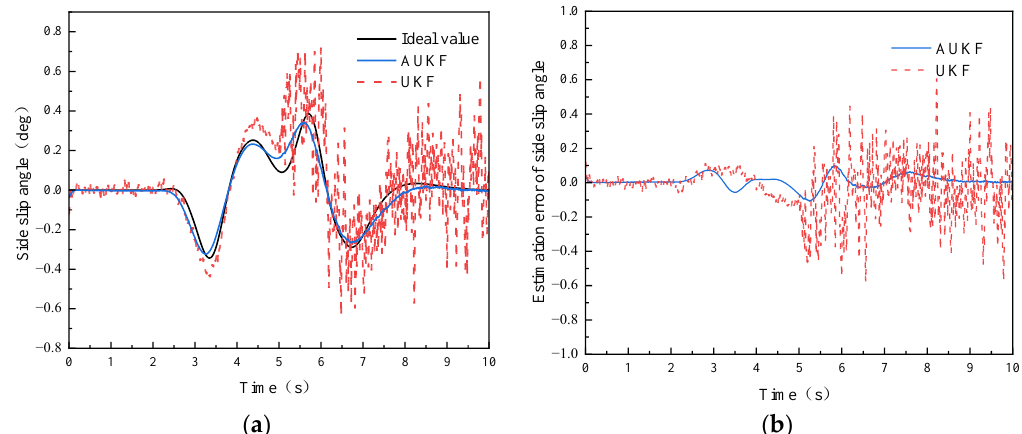
Figure 7. Simulation results of side slip angle. ( a ) Comparison of estimated results and ( b ) comparison of estimated error.